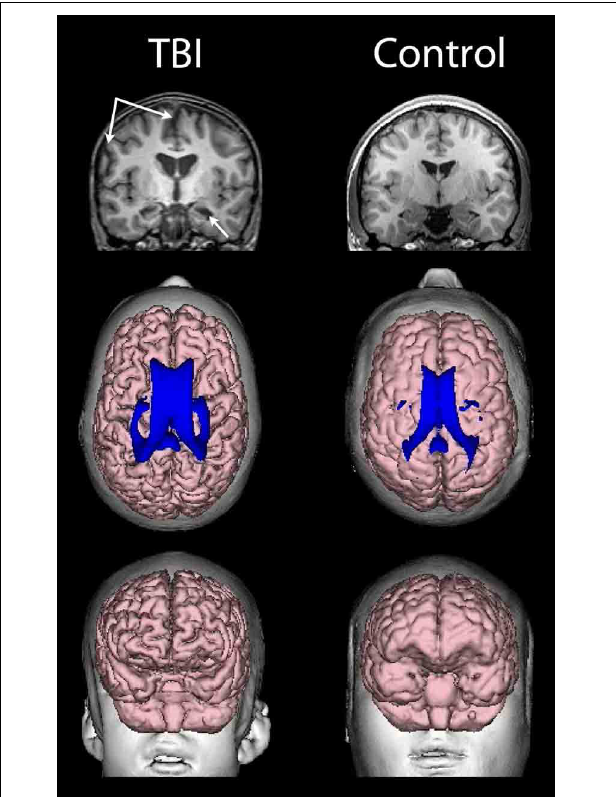
FIGURE 4 | (Top) T1-weighted coronal images of a TBI patient on the left and an age-matched control on the right, both young adolescent males. Upper left-hand arrows point to a prominent interhemispheric fissure and cortical sulci, reflective of whole brain volume loss and generalized cerebral atrophy in the TBI patient. The lower arrow points to an atrophic hippocampus and dilated temporal horn, bilaterally in the TBI patient. (Middle) Dorsal view of a 3-D reconstruction of the ventricle in shown in blue superimposed on the flesh-tone brain surface 3-D reconstruction. Calculating whole brain volume and dividing it by total ventricular volume and multiplying by 100 results in a ventricle-to-brain ratio (VBR) of 5.55, which is markedly deviant from normal, which in typical developing controls is generally in the range of 1.5 with a 0.5 standard deviation [see Blatter et al. (1995) and Chang et al. (2005)]. The control subject VBR was 1.45. Frontal view of the 3-D reconstructed brain (Bottom) of the individual with TBI showing global frontal atrophy with visibly larger cortical sulci compared to the age-match control subject on the right, again reflective of generalized cerebral atrophy. Increased VBR reflects this type of global brain volume loss, ventricular enlargement, gyral shrinkage and sulcal